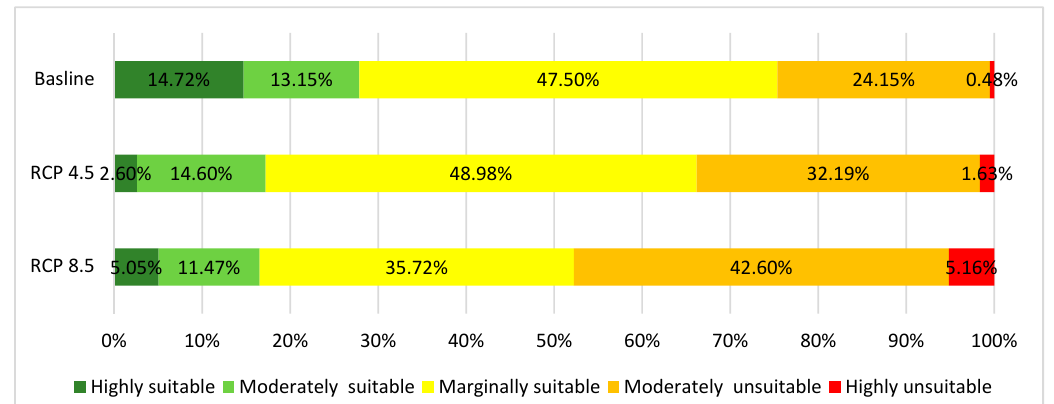
Figure 6. Land suitability classes ( a ) baseline, ( b ) under the RCP4.5 scenario, and ( c ) under the RCP 8.5 scenario.